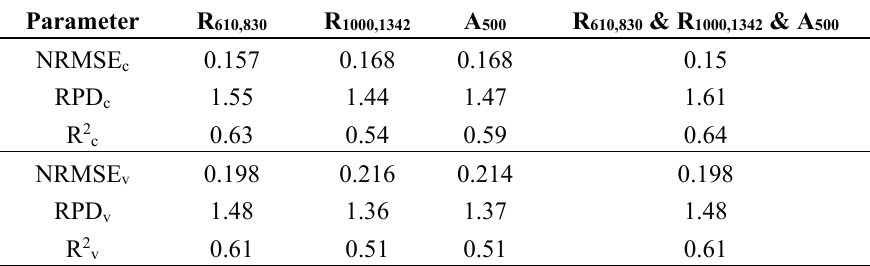
Table 3. Validation parameters for single- and multi-variable linear regression model.